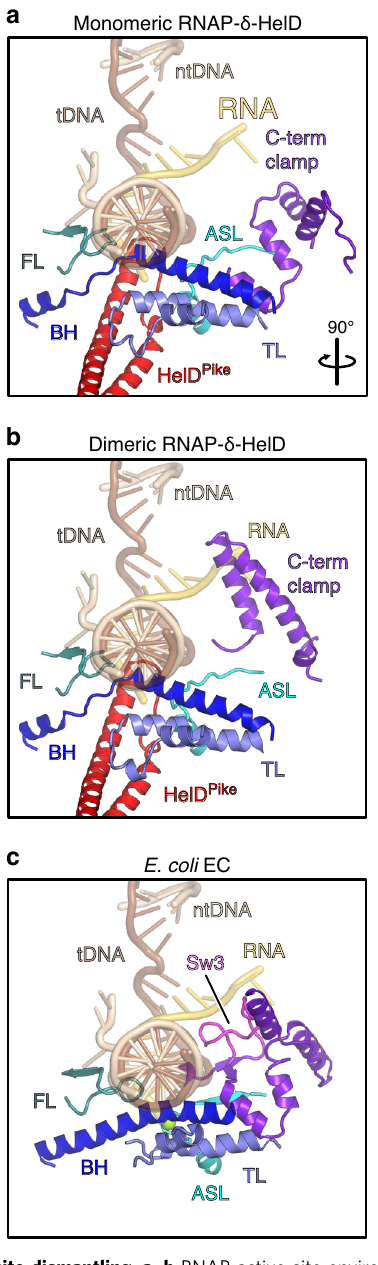
Fig. 5 Active site dismantling. a , b RNAP active site environments in monomeric RNAP- δ -HelD ( a ) and dimeric ( b ) RNAP- δ -HelD, showing HelD-mediated active site dismantling. Comparison to Newing et al. 44 suggests that the presence of δ promotes more severe active site penetration by HelD Pike . Nucleic acids of an E. coli EC (PDB ID 6ALH) were transferred to RNAP- δ -HelD by superposition of the β subunits. β elements: FL (fork loop), teal; C-term clamp (C-terminal clamp), purple; Sw3, magenta. β ′ elements: ASL, cyan; BH (bridge helix), blue; TL (trigger loop), slate blue. The catalytic Mg 2 + ion (green sphere) is lost from RNAP- δ -HelD upon HelD Pike invasion. c Comparison to the RNAP active site environment in an E. coli EC (PDB ID